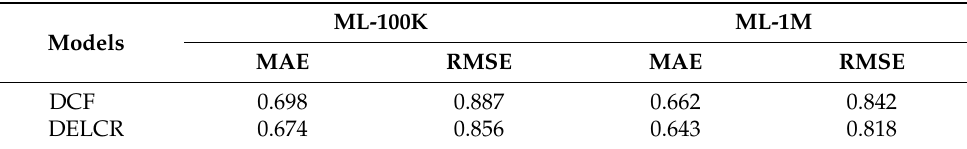
Table 5. Embedding effect for both